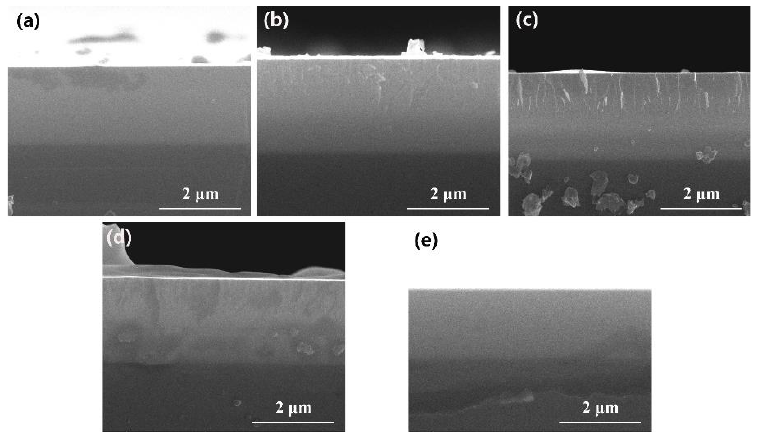
Figure 4. Cross-sectional SEM images of nano-multilayered films with different ZrO 2 thicknesses: (a) 0.2 nm, (b) 0.4 nm, (c) 0.6 nm, (d) 0.8 nm, and (e) 1.2 nm.